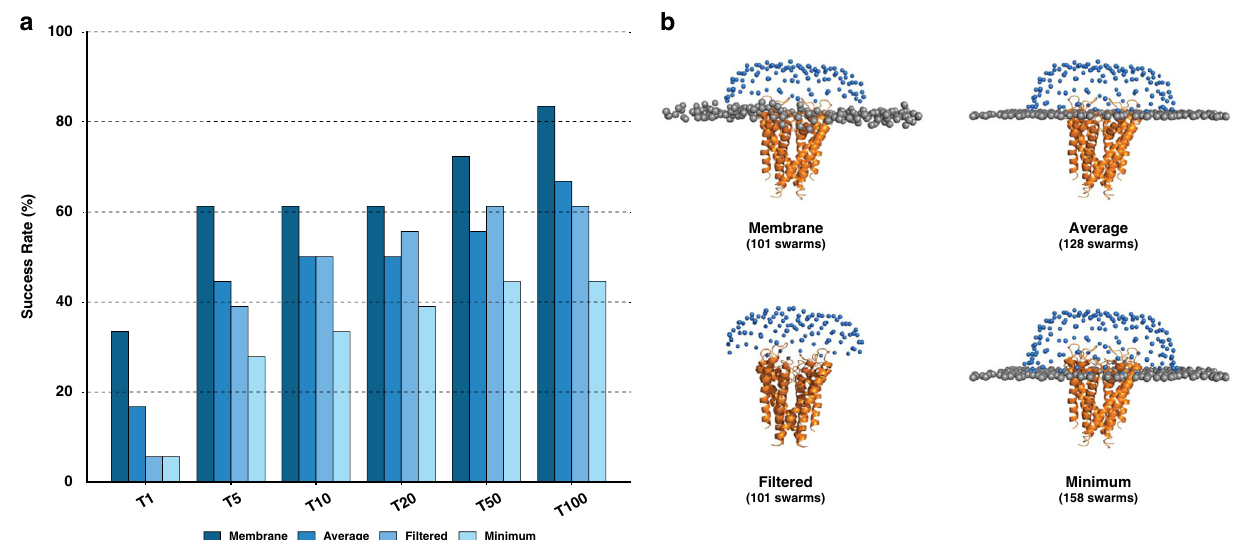
Fig. 4 Analysis of the impact of different membrane de fi nitions onto the docking performance. a Bar plot of the performance of the different membrane setups on the 18 cases of the membrane protein docking dataset (i.e., before re fi nement with HADDOCK). The success rate is de fi ned as the percentage of cases for which an acceptable or higher quality model was found within the selected top N . b Illustration of the different membrane setups on a representative case of the benchmark ( 1k4c ). Source data are provided as an excel fi